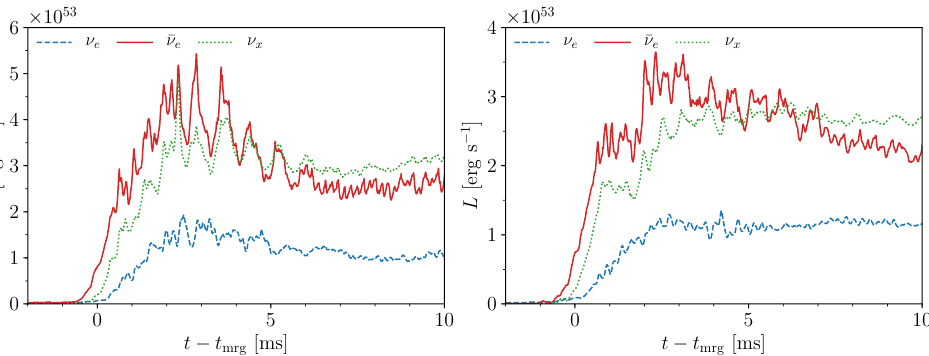
Figure 8. Neutrinos source luminosity evolution for the SFHo- ν simulation ( left panel) and the DD2- ν simulation ( right panel). The electron antineutrinos have higher luminosity until ∼ 5 ms after the merger.